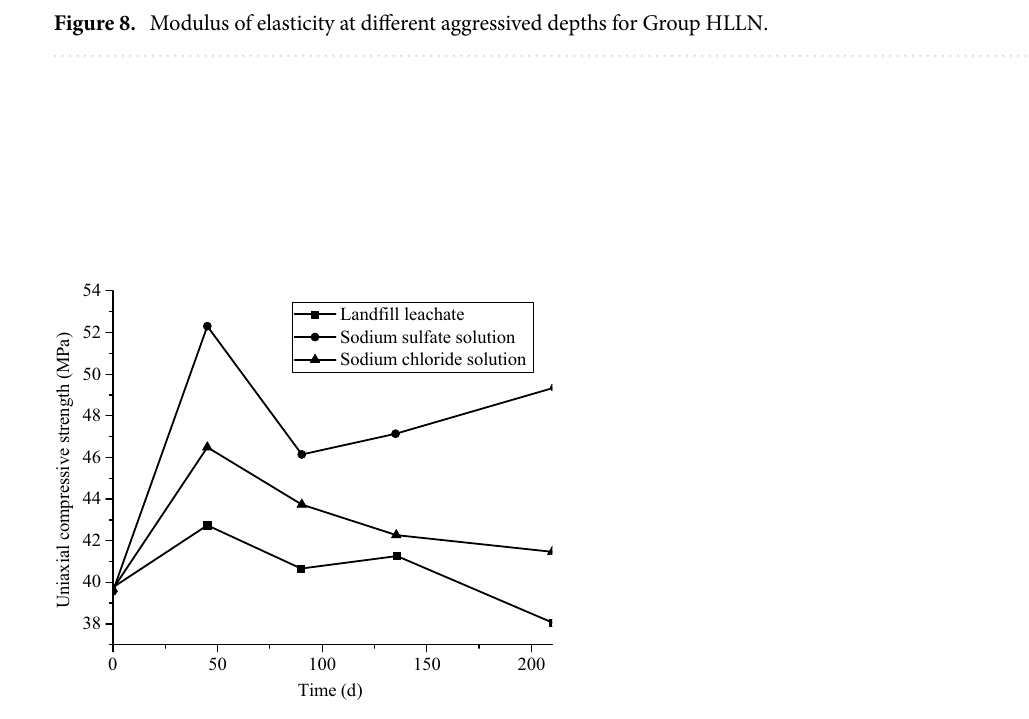
Figure 9. Uniaxial compressive strength of groups HLLN, NSSN, and NSCN after